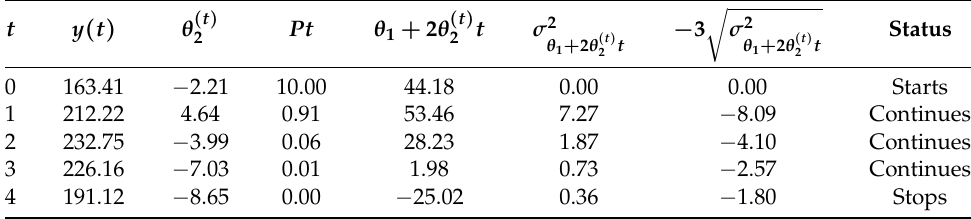
Table 9. Obtained results for the RPR procedure in Case 2.